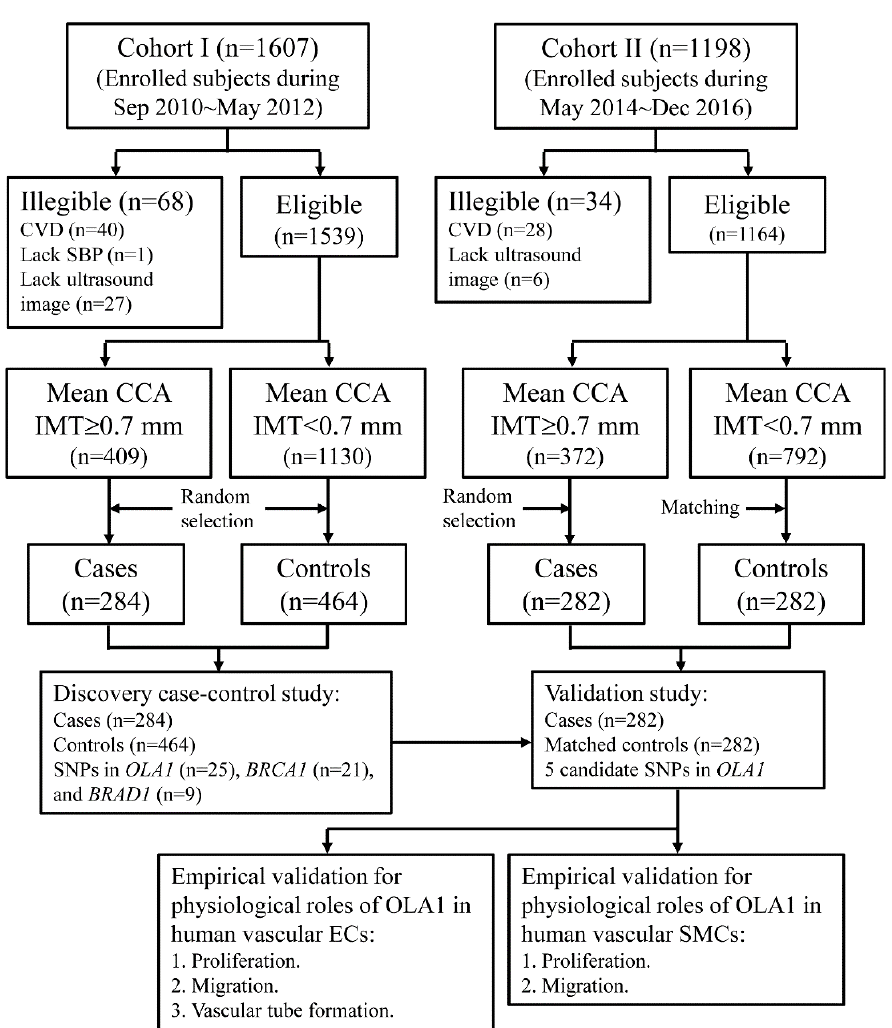
Figure 1. Schematic illustration of approaches to determine genetic association of OLA1 , BRCA1 , and BARD1 with cIMT. Table 1. Association analyses for five candidate SNPs with thicker carotid